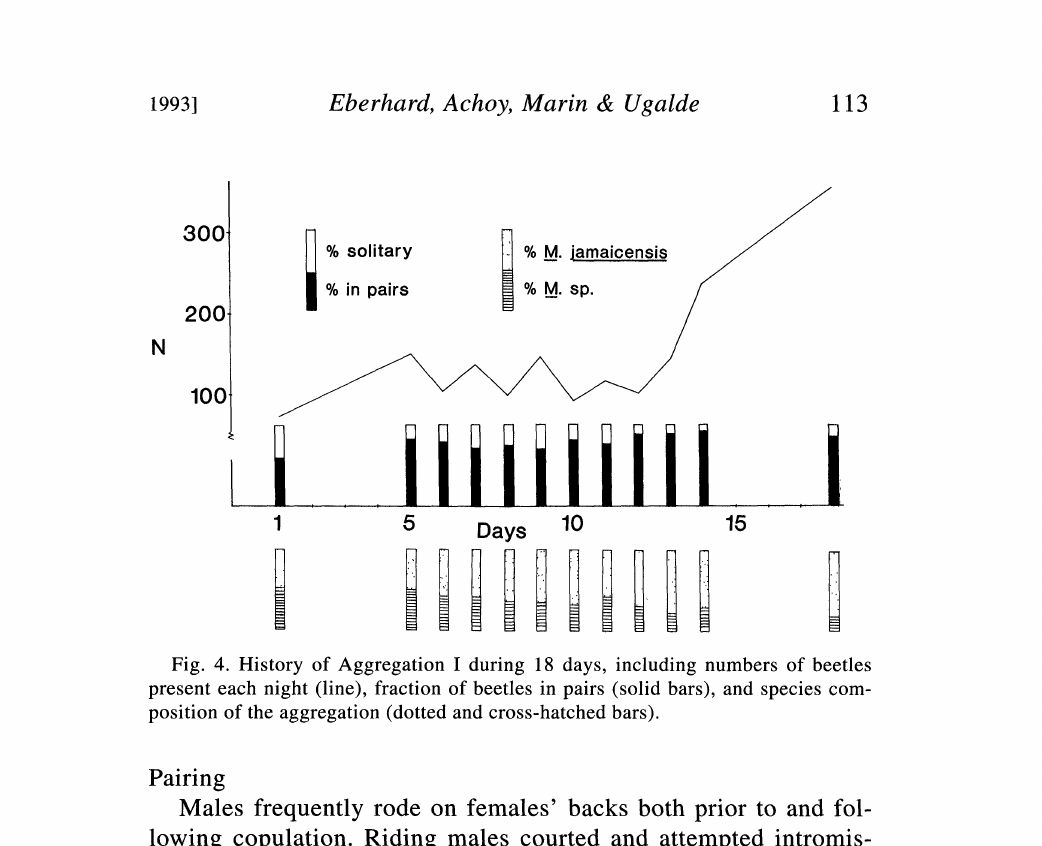
Fig. 4. History of Aggregation during 18 days, including numbers of beetles present each night (line), fraction of beetles in pairs (solid bars), and species com- position of the aggregation (dotted and cross-hatched